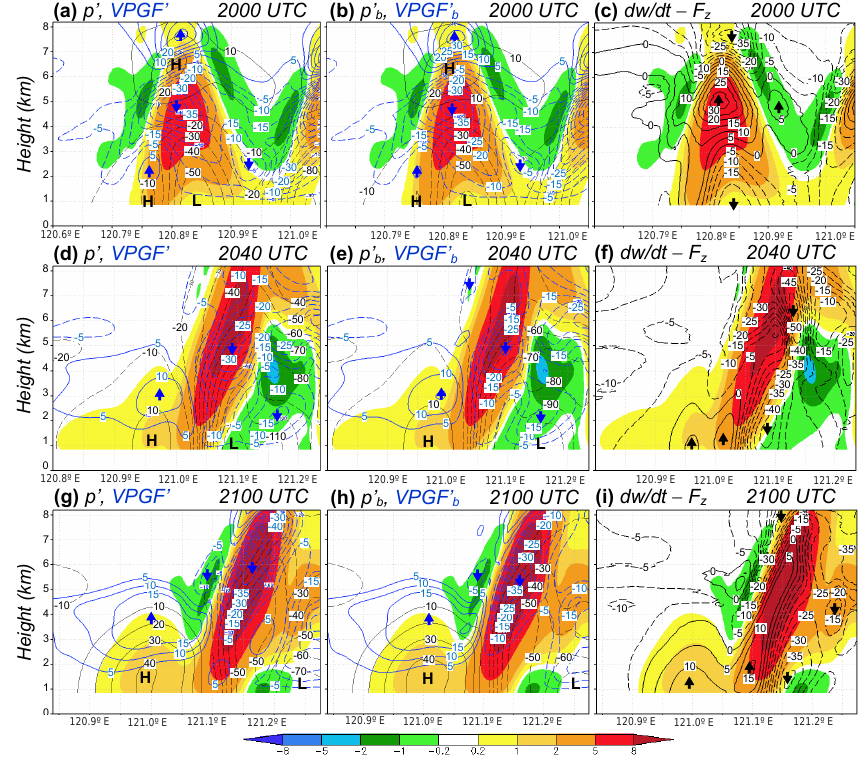
+ p (cid:48) (Pa, black contour, every 10Pa, dashed for negative values) obtained b d